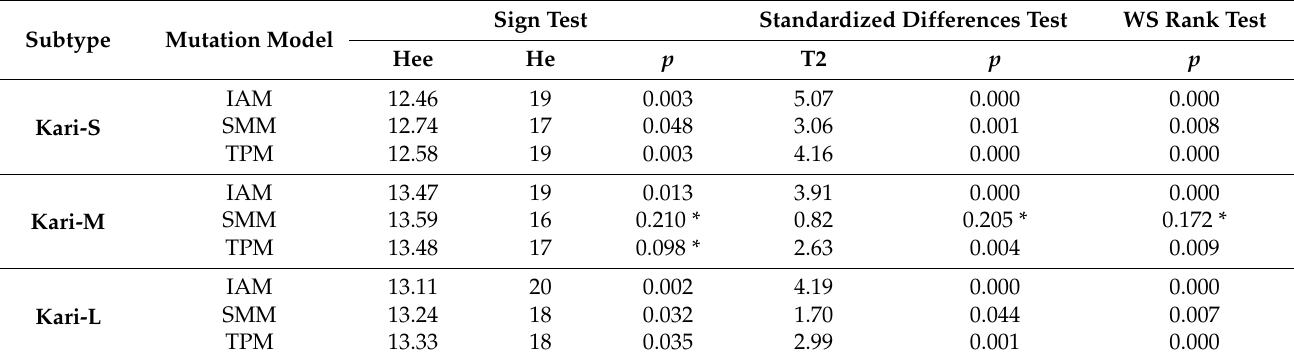
Table 5. Values for mutation drift equilibrium in Kari subtypes under different mutation models and statistical tests.